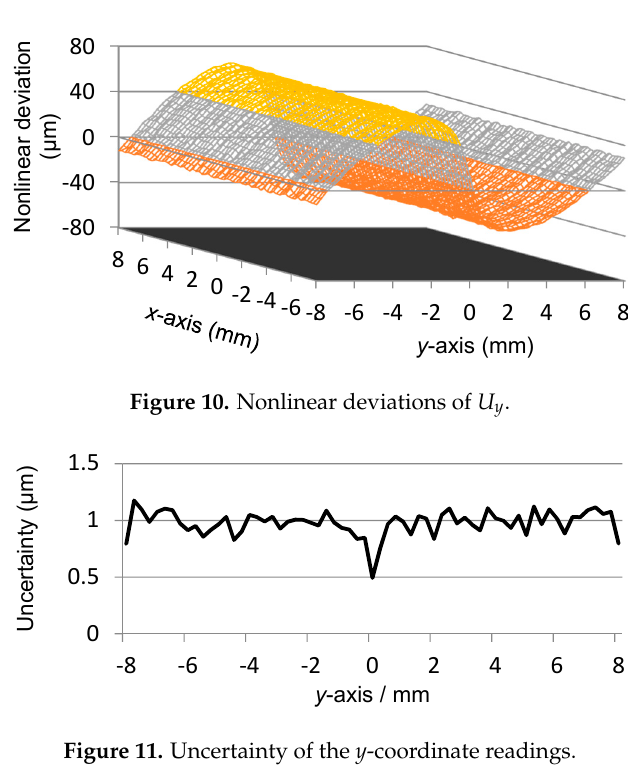
Figure 11. Uncertainty of the y -coordinate readings.